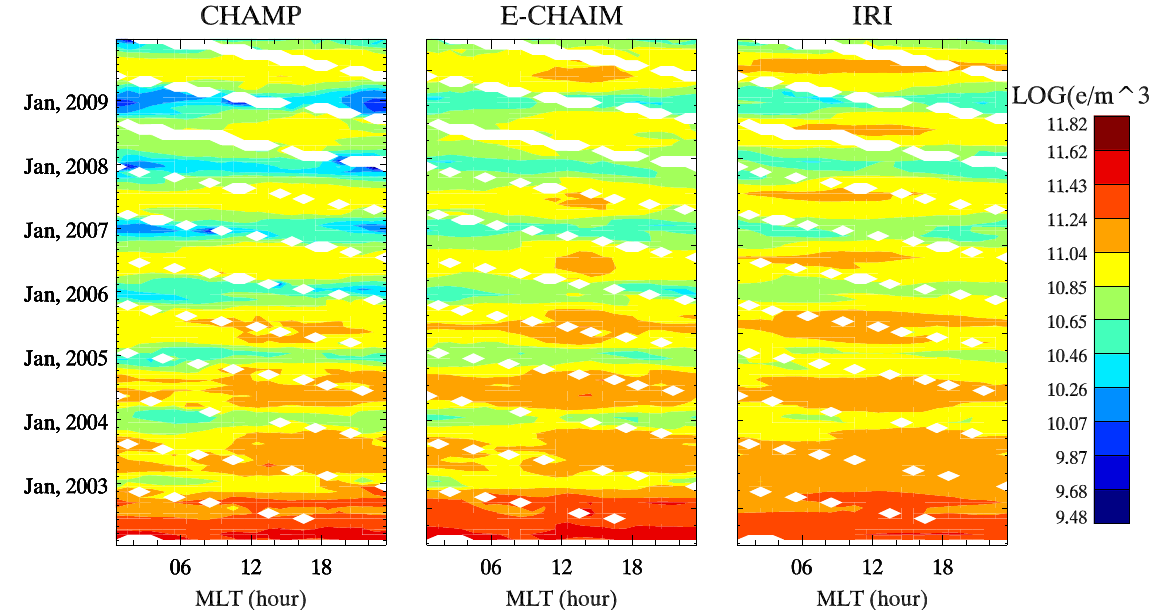
Fig. 17. Log contours of CHAMP (left), E-CHAIM (center), and IRI (right) monthly median electron density at CHAMP orbit altitude from a bin between 75 (cid:1) N and 85 (cid:1) N.